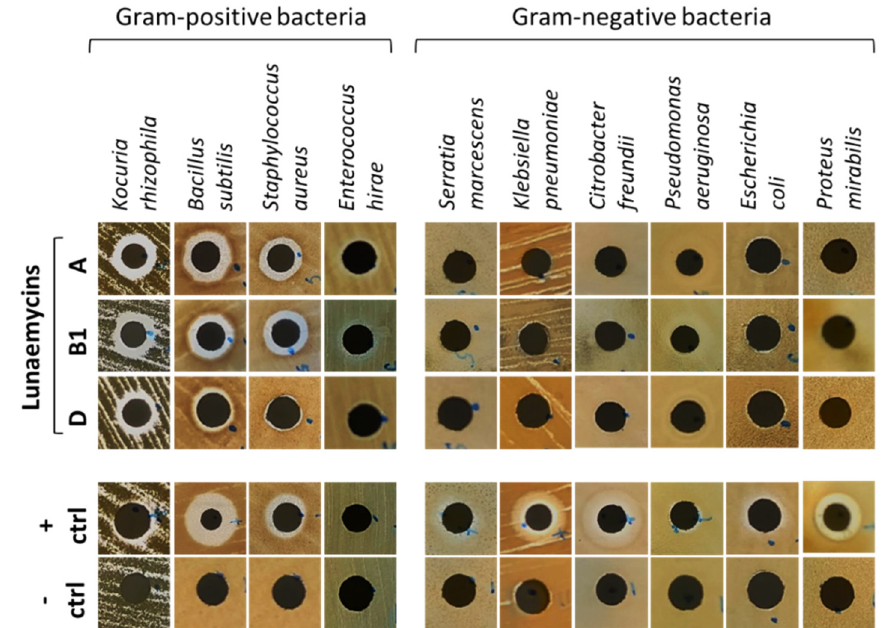
Figure 8. Agar-diffusion antibacterial activity assays of lunaemycins. 0.1 mg/mL of gentamicin was used as positive control, and a water/acetonitrile solution (1/9, v / v ) was used as negative control.